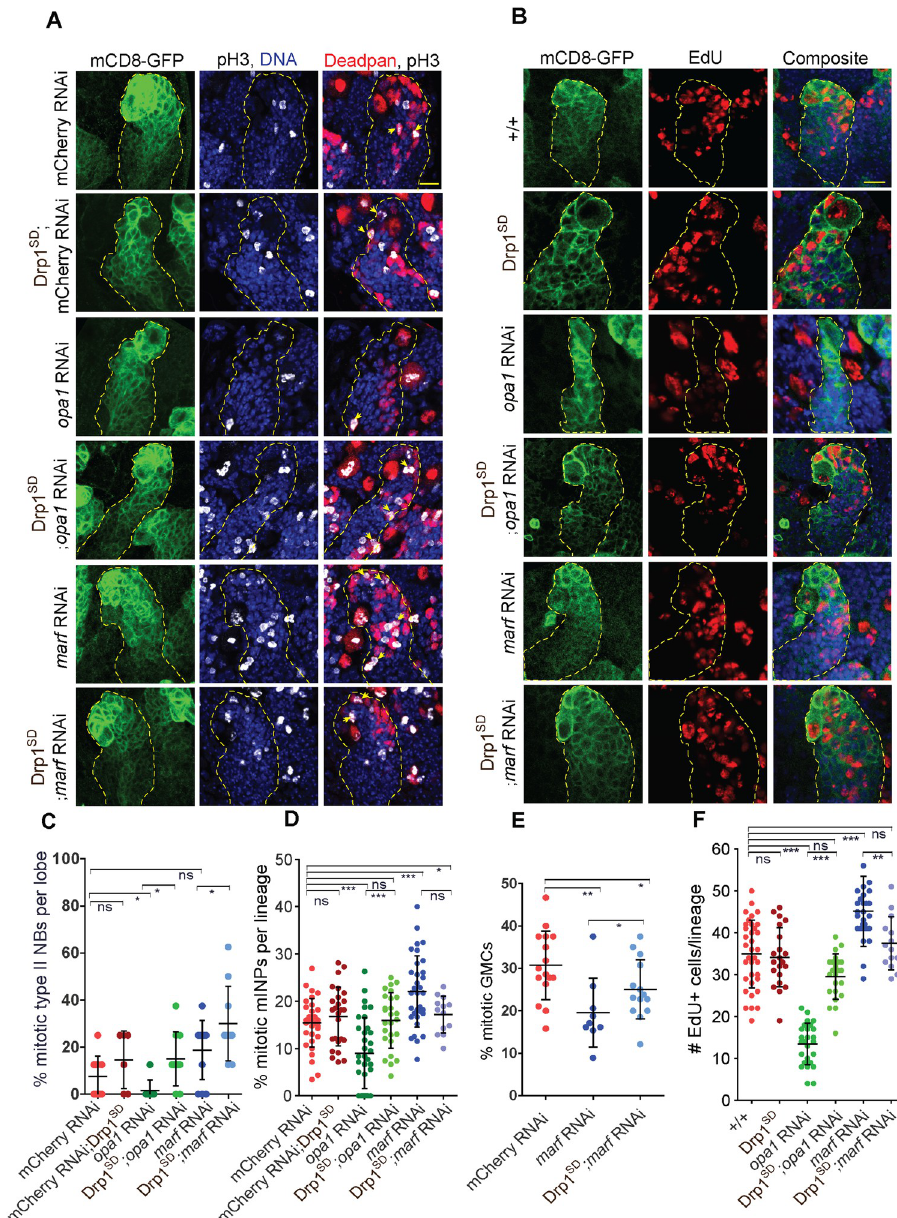
Fig 5. Proliferation defects in Opa1 depleted type II NB lineages are suppressed by overexpression of Drp1 SD . A, C-E: Representative confocal images of type II NB lineages show reduced pH3 positive mature INPs (A) in opa1 RNAi while increase in marf RNAi expressed with pnt -Gal4, mCD8-GFP in the type II NB lineage. Analysis of mitotic type II NBs per brain lobe (C) in mCherry RNAi (10 brain lobes), Drp1 SD (6), opa1 (8), Drp1 SD ; opa1 RNAi (10), marf RNAi (12), Drp1 SD ; marf RNAi (10). Analysis of percentage of dividing mature INPs in type II NB lineages (D, yellow arrows are Dpn+pH3+) in mCherry RNAi (33 Type II NB lineages,7 brains), Drp1 SD ;mCherry RNAi (24,6), opa1 (33,6, Drp1 SD ; opa1 RNAi (26,8), marf RNAi (33,8), Drp1 SD ; marf RNAi (15,5). Quantification of percent dividing GMCs (E) in mCherry RNAi (16 typeII NB lineages, 4 Brains), marf RNAi (9,2), Drp1 SD ; marf RNAi (14,5), Scale bar- 10 μ m. Non-parametric unpaired t-test with Welch’s correction was used for statistical analysis. ns- non-significant, � - p < 0.1, �� - p < 0.01, ��� - p < 0.001. B,F:Representative confocal images of type II NB lineages (mCD8-GFP, green) (yellow dotted line) show decreased number of EdU (red) positive cells per lineage (B) in opa1 RNAi. Quantification of EdU positive cells in type II NB lineages (F) in pnt -Gal4, mCD8-GFP +/+ (35 Type II NB lineages, 6 Brains), Drp1 SD (21,7), opa1 RNAi (26,6), Drp1 SD ; opa1 RNAi (23,7), marf RNAi (29,7), Drp1 SD ; marf RNAi (14,5). Statistical analysis was done by using unpaired t-test.ns- non-significant, �� - p < 0.01, ��� - p < 0.001.